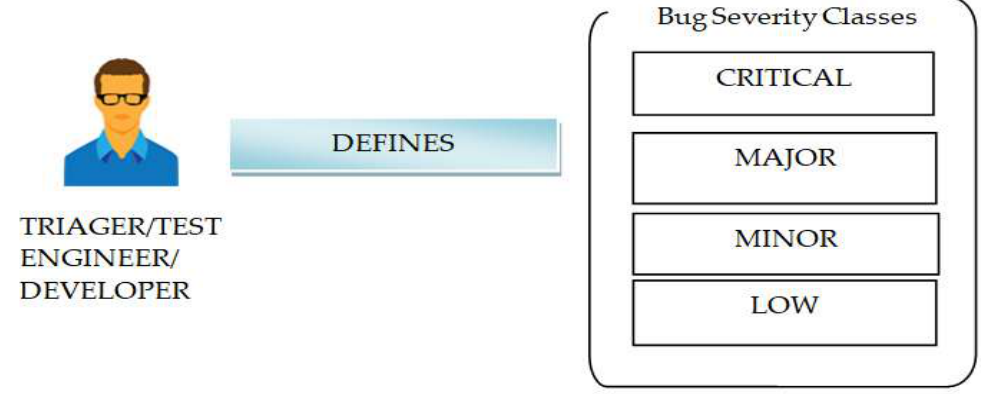
Figure 1. The basic classes of bug severity .